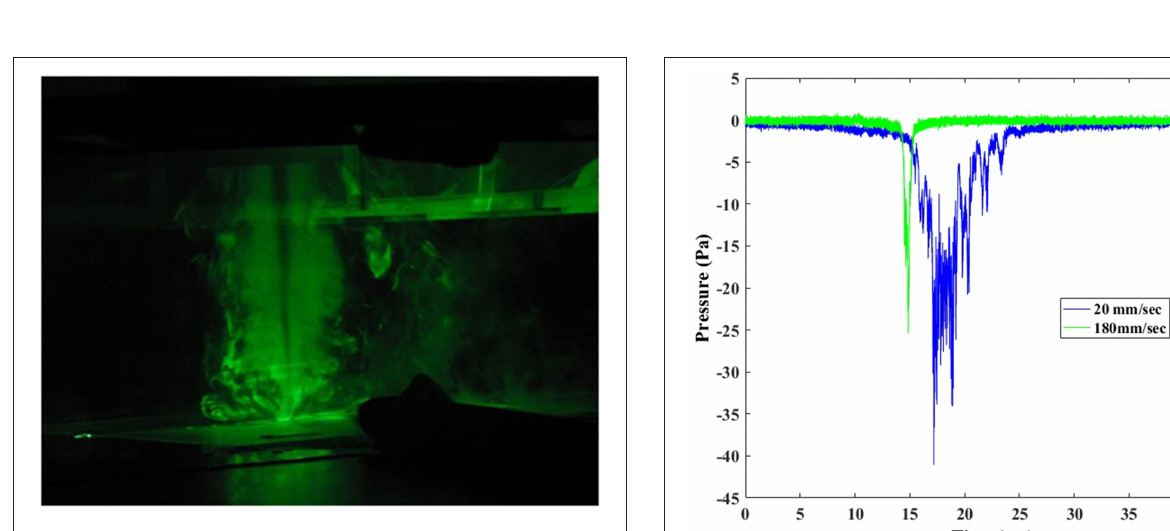
FIGURE 3 | Flow visualization showing tornado vortex core generated in the simulator.